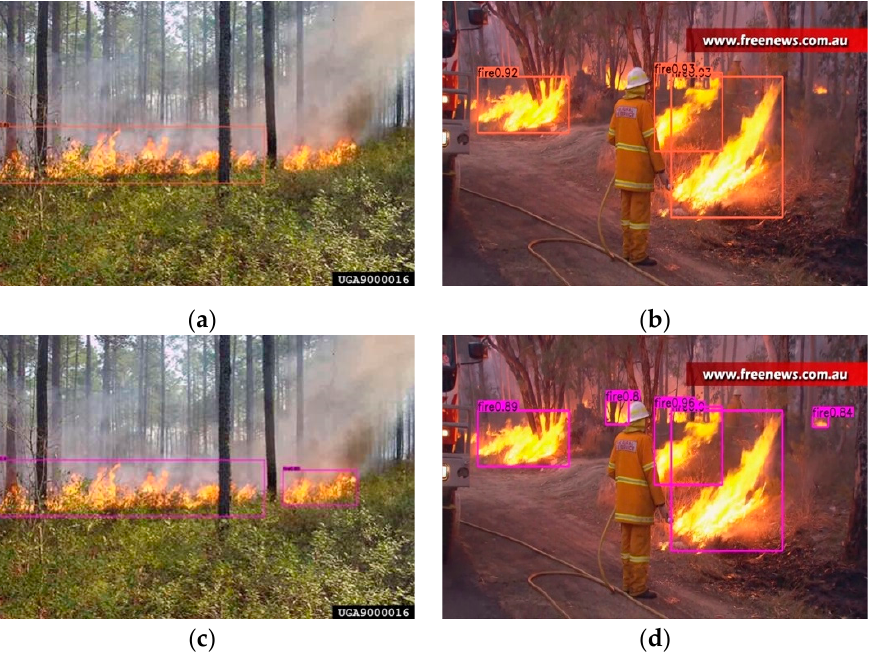
Figure 6. EfficientDet is a more “careful” target detector than Yolov5. ( a ) Yolov5 missed a flame target; ( b ) Yolov5 missed two flame targets; ( c ) EfficientDet detection of all flame areas; ( d ) EfficientDet detected five flame targets.